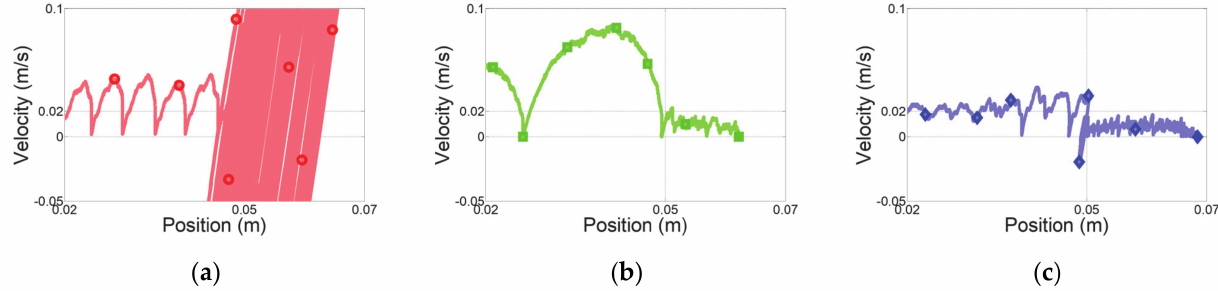
Figure 13. Position–velocity graphs along x axis for collision with virtual object. Admittance control with ( a ) low and ( b ) high admittance parameters and ( c ) proposed variable admittance control based on